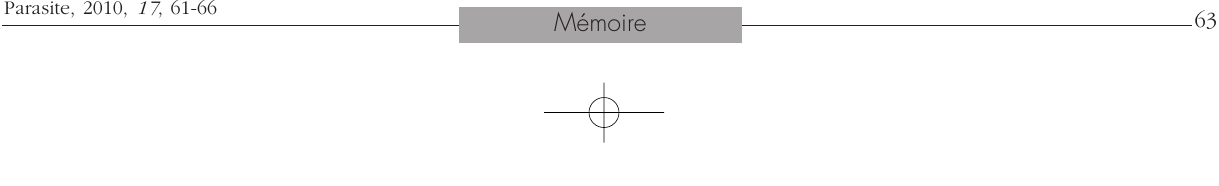
Table II. – Number and proportion of animals positive for different tests, by study